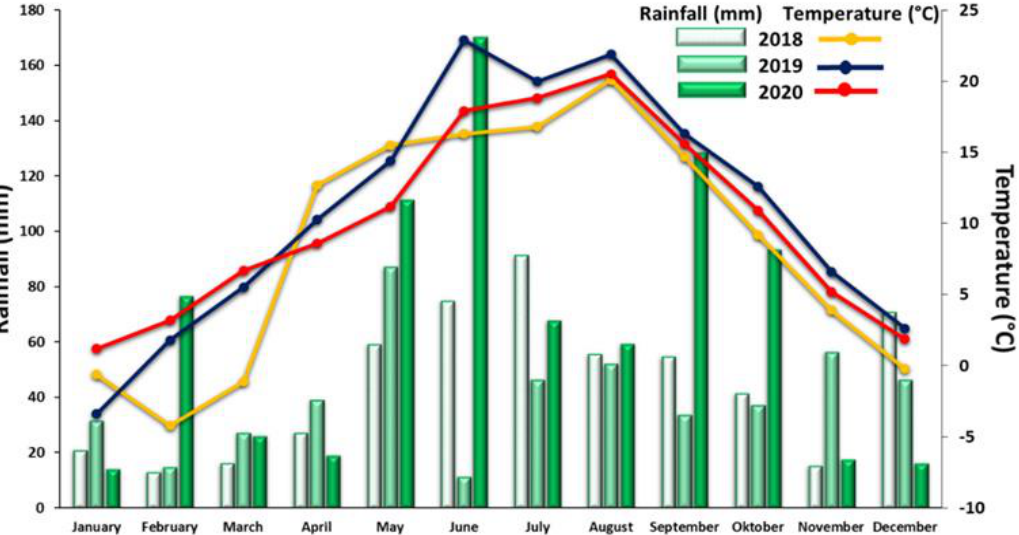
Figure 2. Average monthly temperatures and monthly rainfall totals in the experimental area during the research period.